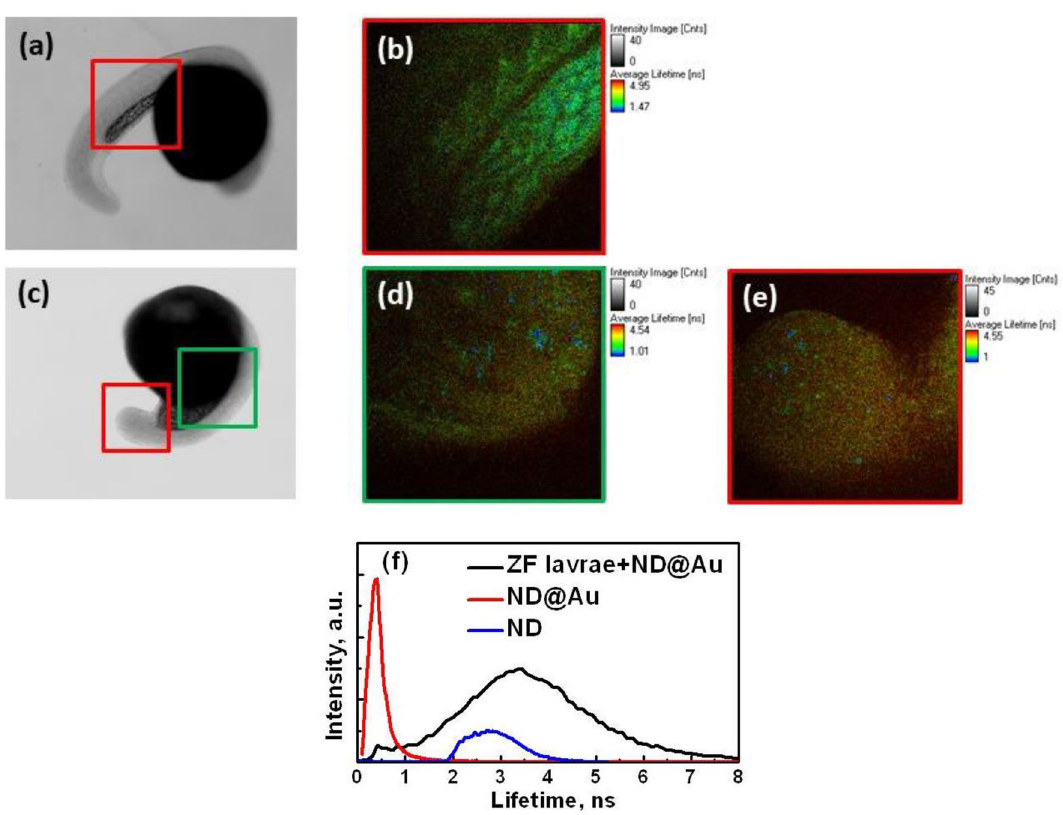
Figure 8. ND@Au imaging in the Zebra fish larvae ( a ) optical image and ( b ) FLIM of control larvae, without ND@Au; ( c ) optical image and ( d green box; e red box) FLIM of larvae developing with injected ND@Au; ( f ) histograms of lifetime distribution along the image ( d ) (zebrafish (ZF) Larvae + ND@Au) and image ( c ) from Fig. 2 (ND@Au), and for control ND. Zebrafish larvae FLIM was performed at 800 nm wavelength laser excitation and laser power at the input to PicoHarb scanning system 20